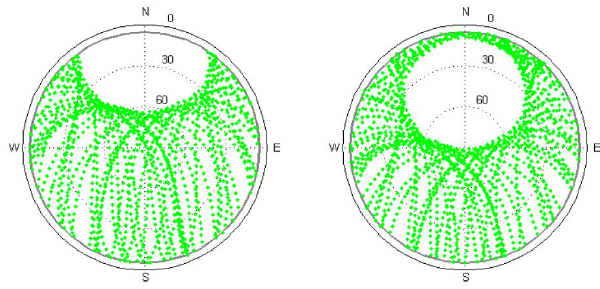
Figure 5: Skyplot with satellite tracks during 24 hours at latitudes 36 ∘ North (left) and 57 ∘ North (right).